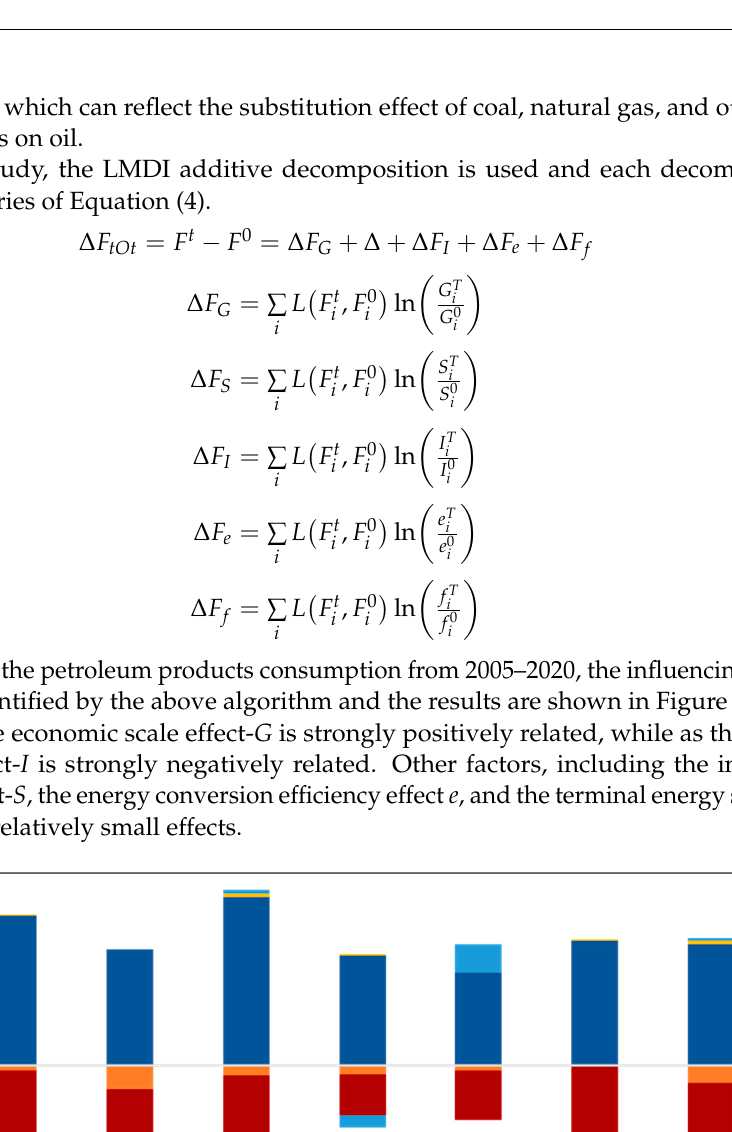
Figure 6. The impact of key factors on the consumption of petroleum products.